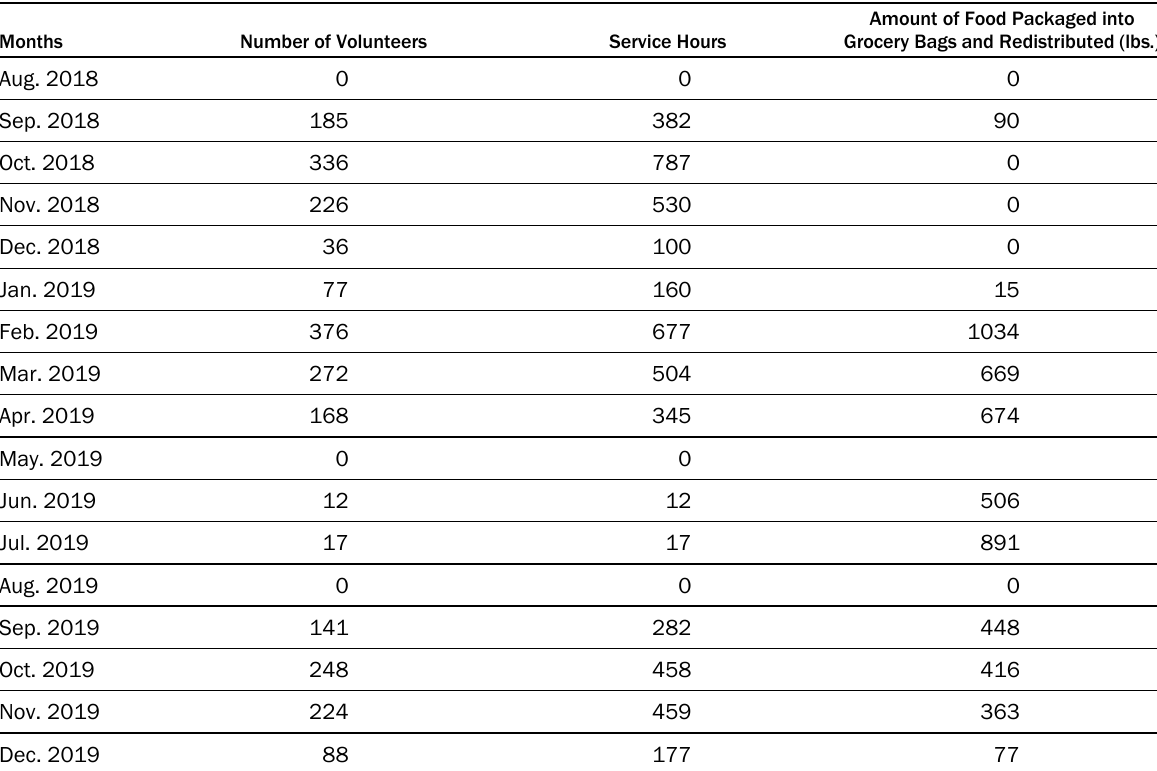
Table 1. Number of Student Volunteers, Service Hours, Amount of Food Packaged into Grocery Bags and Redistributed Following Weekly Meal Preparation over 18-month Period Months Number of Volunteers Service